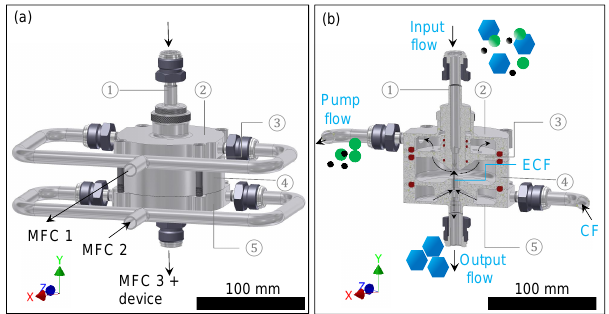
Figure 1. Schematic description of the IS-PCVI outfit (a) and the geometry inside the IS-PCVI (b) . The IS-PCVI consists of 5 compo- nents; (1) inlet nozzle, (2) top compartment outfitted with the pump flow outlet, (3) rejection plate, (4) middle compartment facilitat- ing the effective counterflow (ECF), and (5) bottom compartment equipped with the counterflow (CF) inlet. The arrows represent the directions of air flows utilized to operate the IS-PCVI. Separation of ice crystals (blue hexagons) from droplet (green spheres) and inter- stitial particles (black spheres) takes place at the location where the upward effective counterflow (ECF = CF − output flow) is